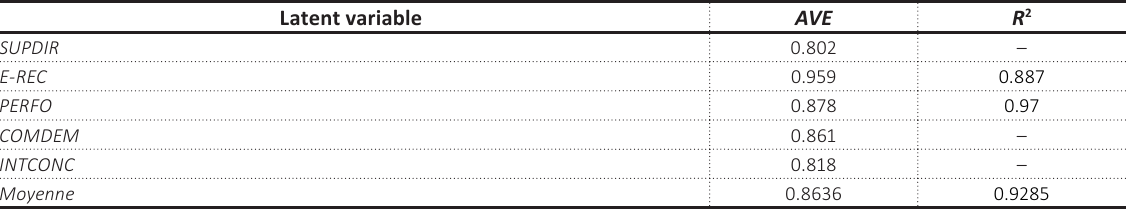
Table B3. GoF calculation element